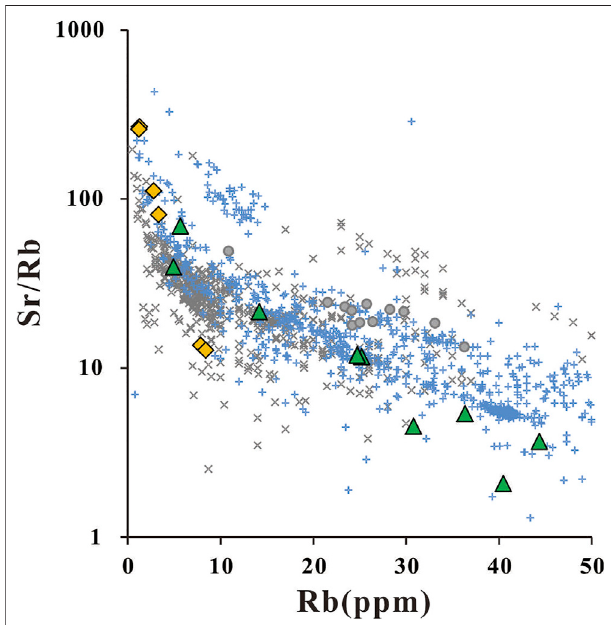
FIGURE 10 | Plots of Sr/Rb VS Rb. Symbols are the same as Figure 9 , the original data of PURE and MITX are listed in Supplementary Table S5 original trace data. Then we used the same computing method mentioned in Figure 5 to revise our data. The trace element data of melts from pure basic rocks (Xiong et al., 2006; Qian and Hermann, 2013) are out of the variation range, so there are no OP data shown in this fi gure.